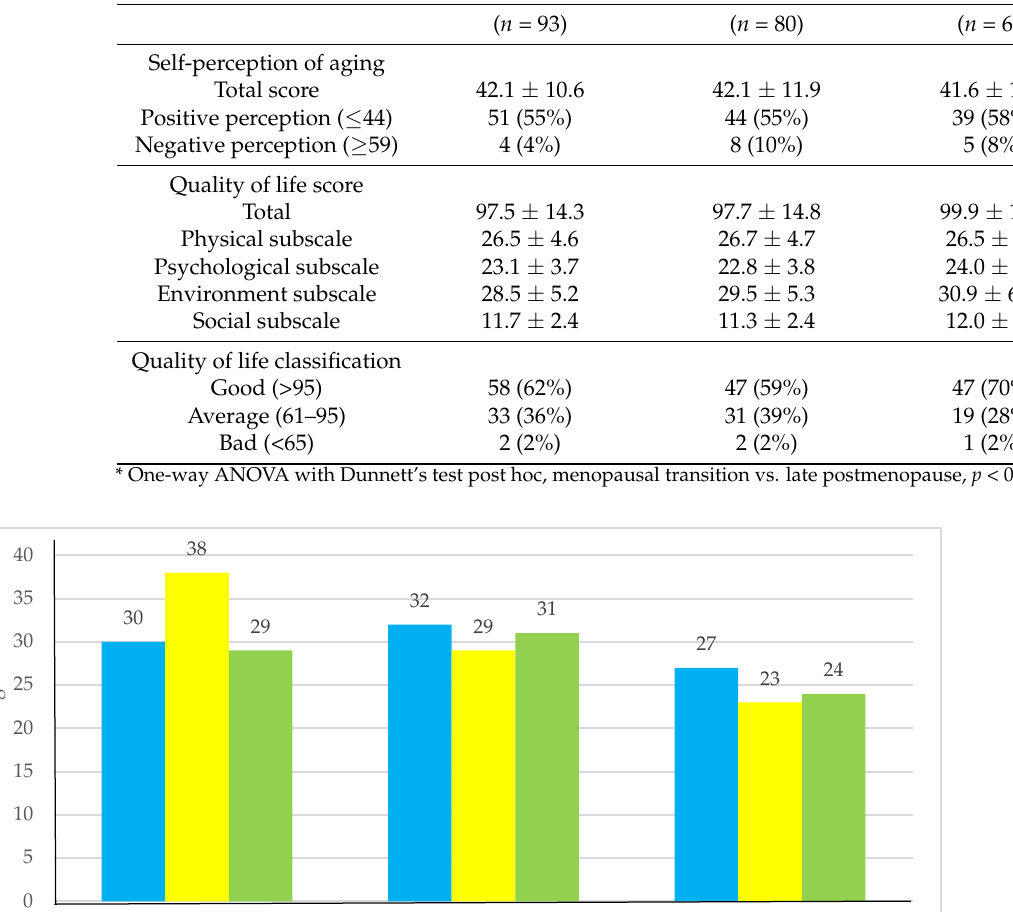
Table 2. Self ‐ perception of aging and the quality of life by study group.